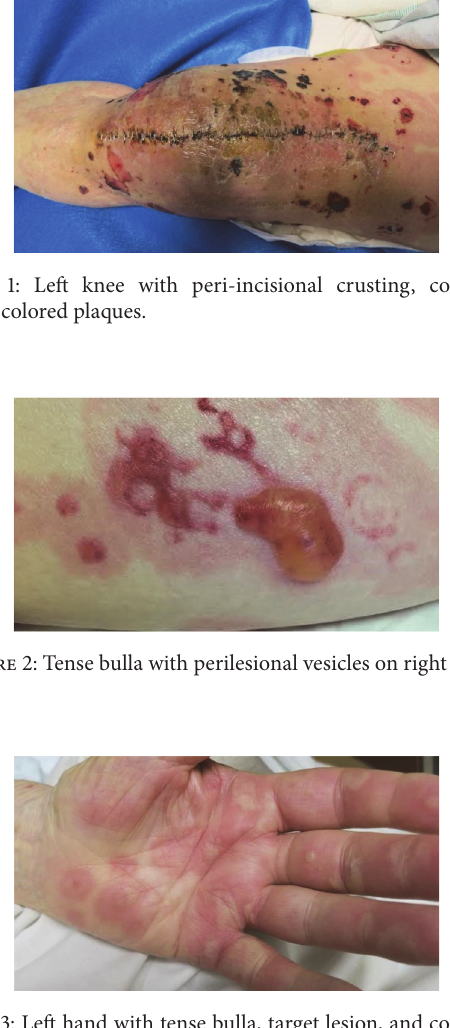
Figure 3: Left hand with tense bulla, target lesion, and coalescing, salmon-colored plaques.